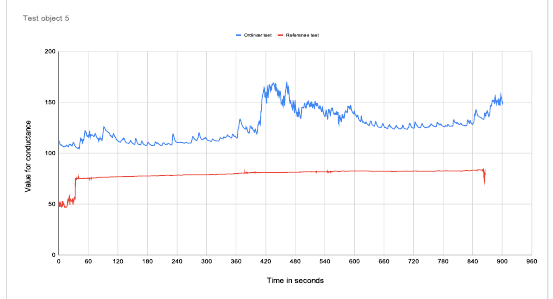
Figure 10: Plot of conductance for test subject 5 Percentage change with electrodes in palm: 38,18% Percentage change with electrodes on arm: